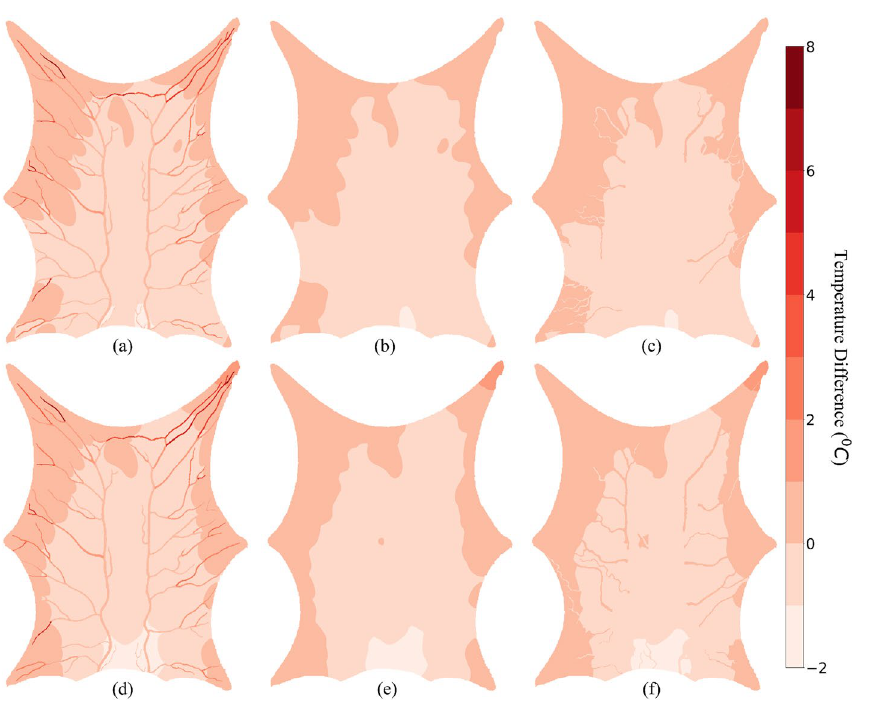
Figure 10. Effect of convective heat exchange between blood and tissue. The positive temperature difference shows the regions which are warmer when we use the PBM assumption and the negative temperature difference shows the region where the WJM assumption results in higher temperature. ǫ = 10 mm : ( a ) Layer 1, ( b ) Layer 2, ( c ) Layer 3 ǫ = 5 mm : ( d ) Layer 1, ( e ) Layer 2, ( f ) Layer